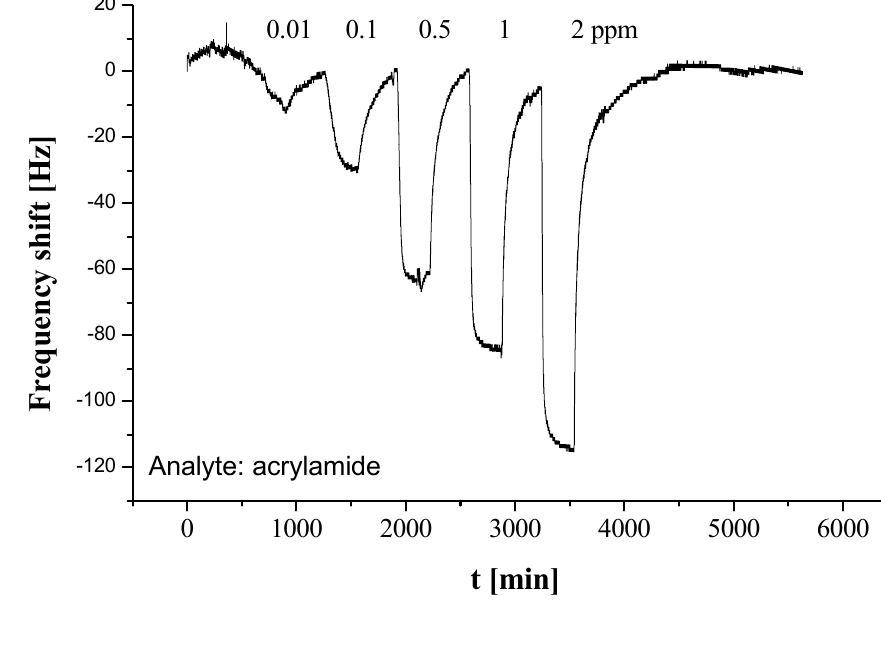
Figure 3. Sensor response of a QMB quartz coated with 9 to a series of increasing acrylamide